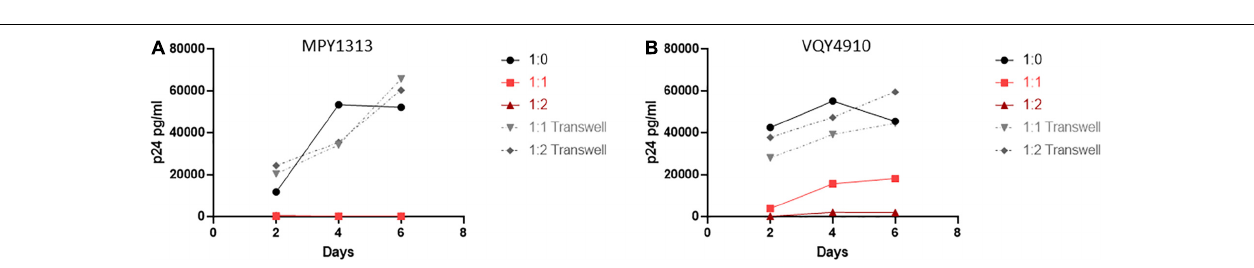
FIGURE 6 | Pre-therapy CD8 + T-cells suppress replication in post-therapy CD4 + T-cells. Samples from before and after initiation of therapy were used to determine if pre-therapy samples could control viral replication in post-therapy samples. (A) PBMCs from MPY1313 and isolated CD4 + and CD8 + T-cells from (B) MPY1313 and (C) VQY4910 pre and post-therapy were mixed at the indicated ratios (post:pre) and infected with NL4-3. Supernatant was collected every 48 h and virus levels were determined by p24 ELISA.